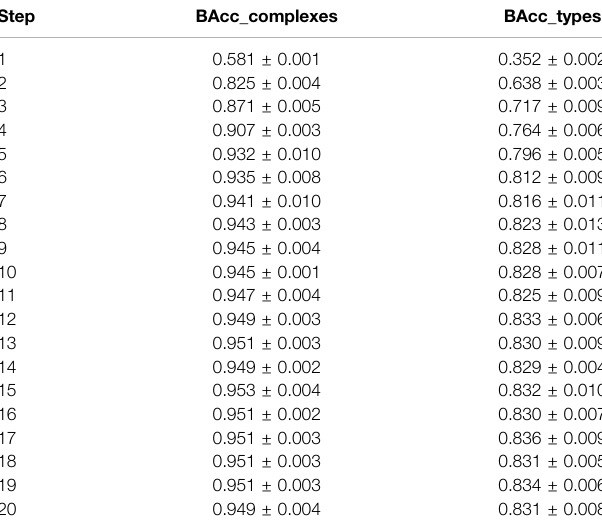
TABLE 9 | Average rank per feature for the classi fi cation of complexes during sequential feature selection with balanced accuracy on spectral